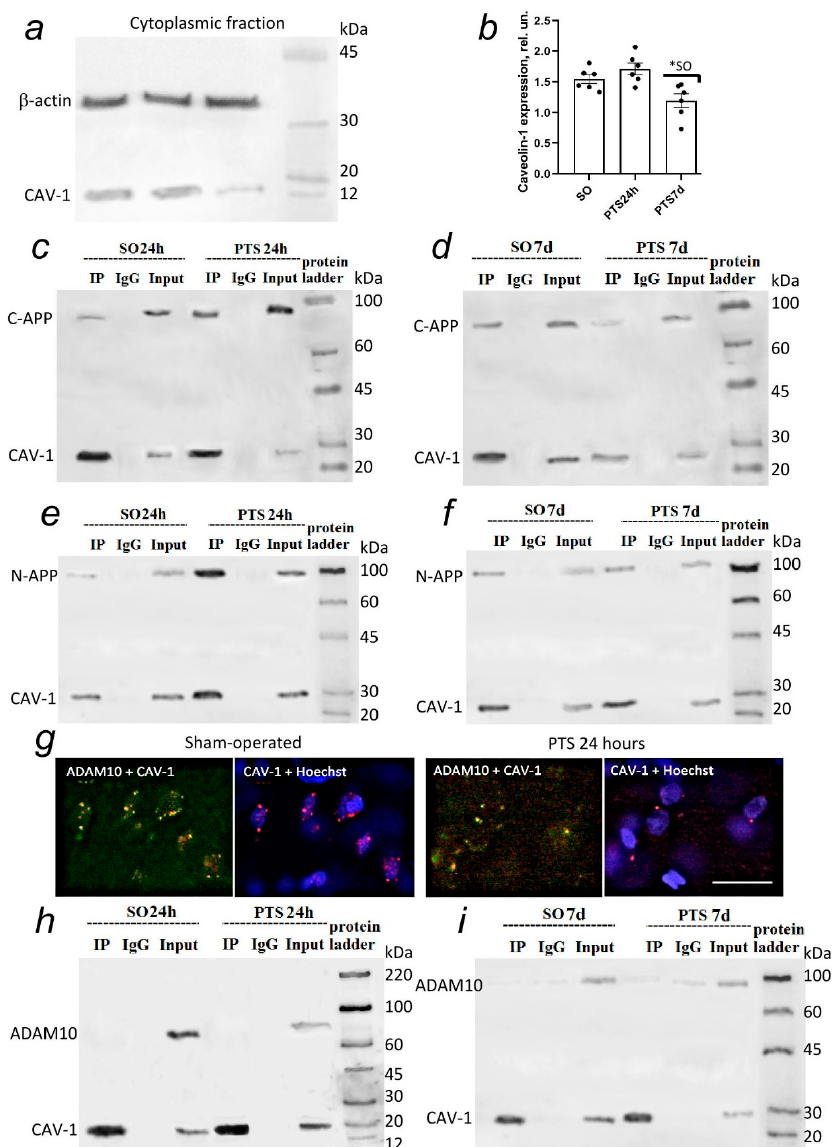
Figure 4. ( a ) Caveolin-1 (CAV-1) in the cytoplasmic fraction of the cortex of sham-operated animals (SO) and at 24 (PTS 24 h) and 7 days (PTS 7d) after PTS; ( b ) Caveolin-1 level in relative units at different times after PTS. The indices of the groups of sham-operated animals at 24 h, and 7 days after irradiation had no statistically significant differences. The result of Western blot analysis of co-immunoprecipitation of caveolin-1 protein and C-APP ( c , d ), or N-APP ( e , f ), or ADAM10 ( h , i ) in the cytoplasmic fraction of penumbra tissue at 24 h (PTS 24 h) and 7 days (PTS 7d) after PTS. Control group: cerebral cortex of sham-operated rats (SO24h or SO7d, respectively). Endogenous caveolin-1 proteins were immunoprecipitated (IP) with anti-caveolin-1 antibody, and co-precipitated C-APP or N-APP, or ADAM10 proteins were subsequently detected with anti-C-APP or N-APP, or ADAM10 antibodies, respectively. The expression level of caveolin-1 served as a Co-IP control. Negative control: normal IgG: 3 µ g normal mouse IgG was added instead of anti-precipitating protein antibodies to exclude non-specific binding. Positive control: the original sample, not subjected to immunoprecipitation (input). To identify proteins on the blot, a molecular weight marker (protein ladder) was used. ( g ) Immunofluorescence and image overlay ADAM10 (green) and caveolin-1 (red) or caveolin-1 (red) and Hoechst (blue) in the cortex of sham-operated animals (SO) and at 24 h (PTS 24 h) after PTS. Scale bar 50 µ m. One-way ANOVA. M ± SEM. n = 6–8. * p < 0.05 compared to the